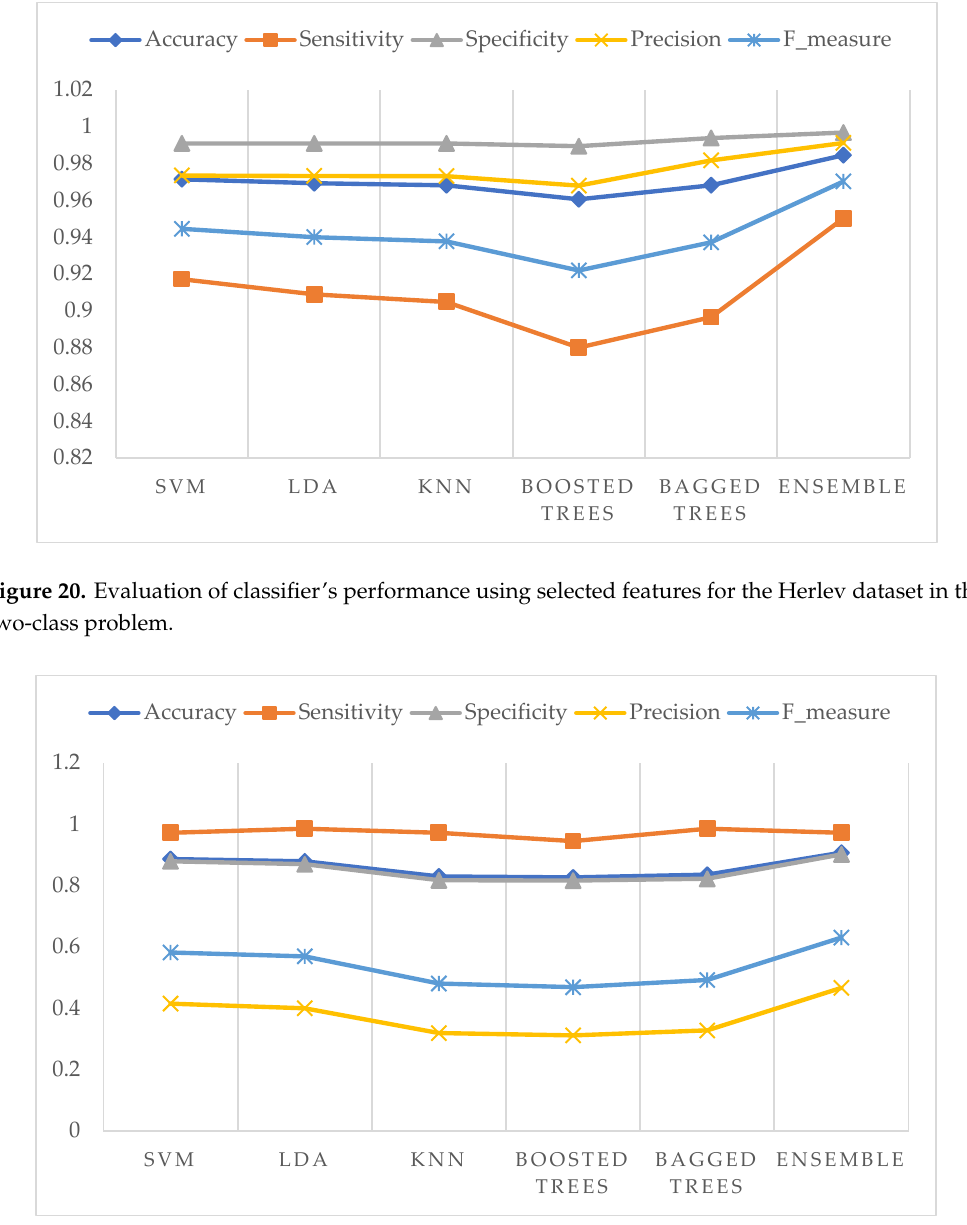
Figure 21. Evaluation of classifier’s performance using selected features for the Herlev dataset in the seven-class problem.